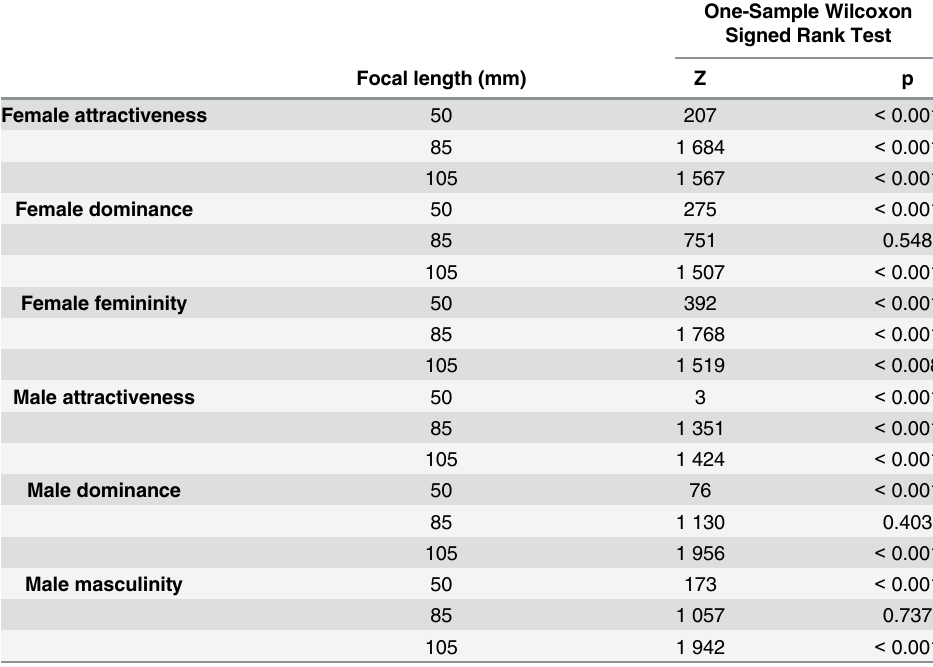
Table 1. Comparison of the proportion of first choices for each focal length against random distribu- tion (i.e.,